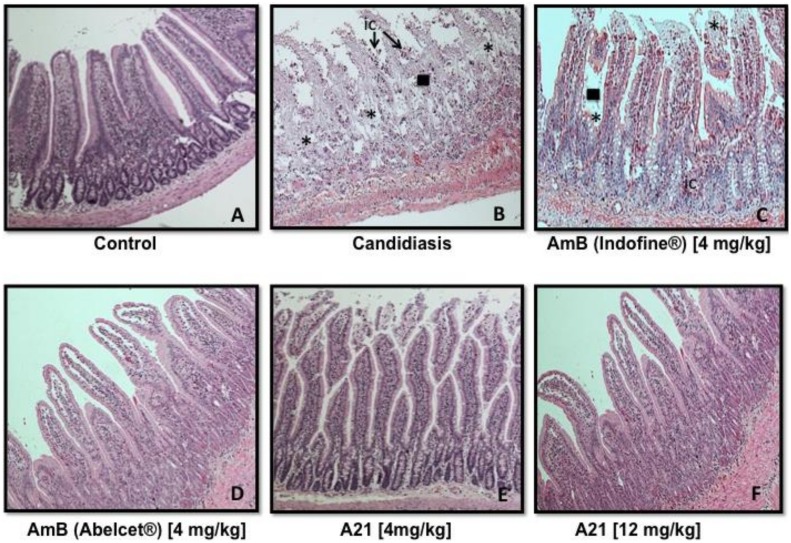
Histopathological analysis of intestinal epithelium obtained five weeks after Candida albicans inoculation in mice.(A) Intestinal epithelium of Balb-C mouse with normal appearance. (B) Intestinal epithelium showing severe damage with necrotic enteritis. We can observe the loss of microvilli (■), presence of inflammatory cells (ic) and cellular lysis (*) is observed. (C) Intestinal epithelium from a representative mouse with candidiasis treated with a daily IP dose of 4 mg/kg AmB (DMSO) during the last two of the five weeks. Loss of microvilli (■), presence of inflammatory cells (ic), and cellular lysis (*) is observed. (D) Intestinal epithelium from a representative mouse with candidiasis treated with a daily IP dose of 4 mg/kg AmB (Abelcet®) during the last two of the five weeks. The kidney appears normal and has abundant caliciform cells. (E) Intestinal epithelium from a representative mouse with candidiasis treated with a daily IP dose of 4 mg/kg A21 during the last two of the five weeks. Epithelium with normal appearance. (F) Intestinal epithelium from a representative mouse with candidiasis treated with a daily IP dose of 12 mg/kg A21 during the last two of the five weeks. Epithelium with normal appearance.